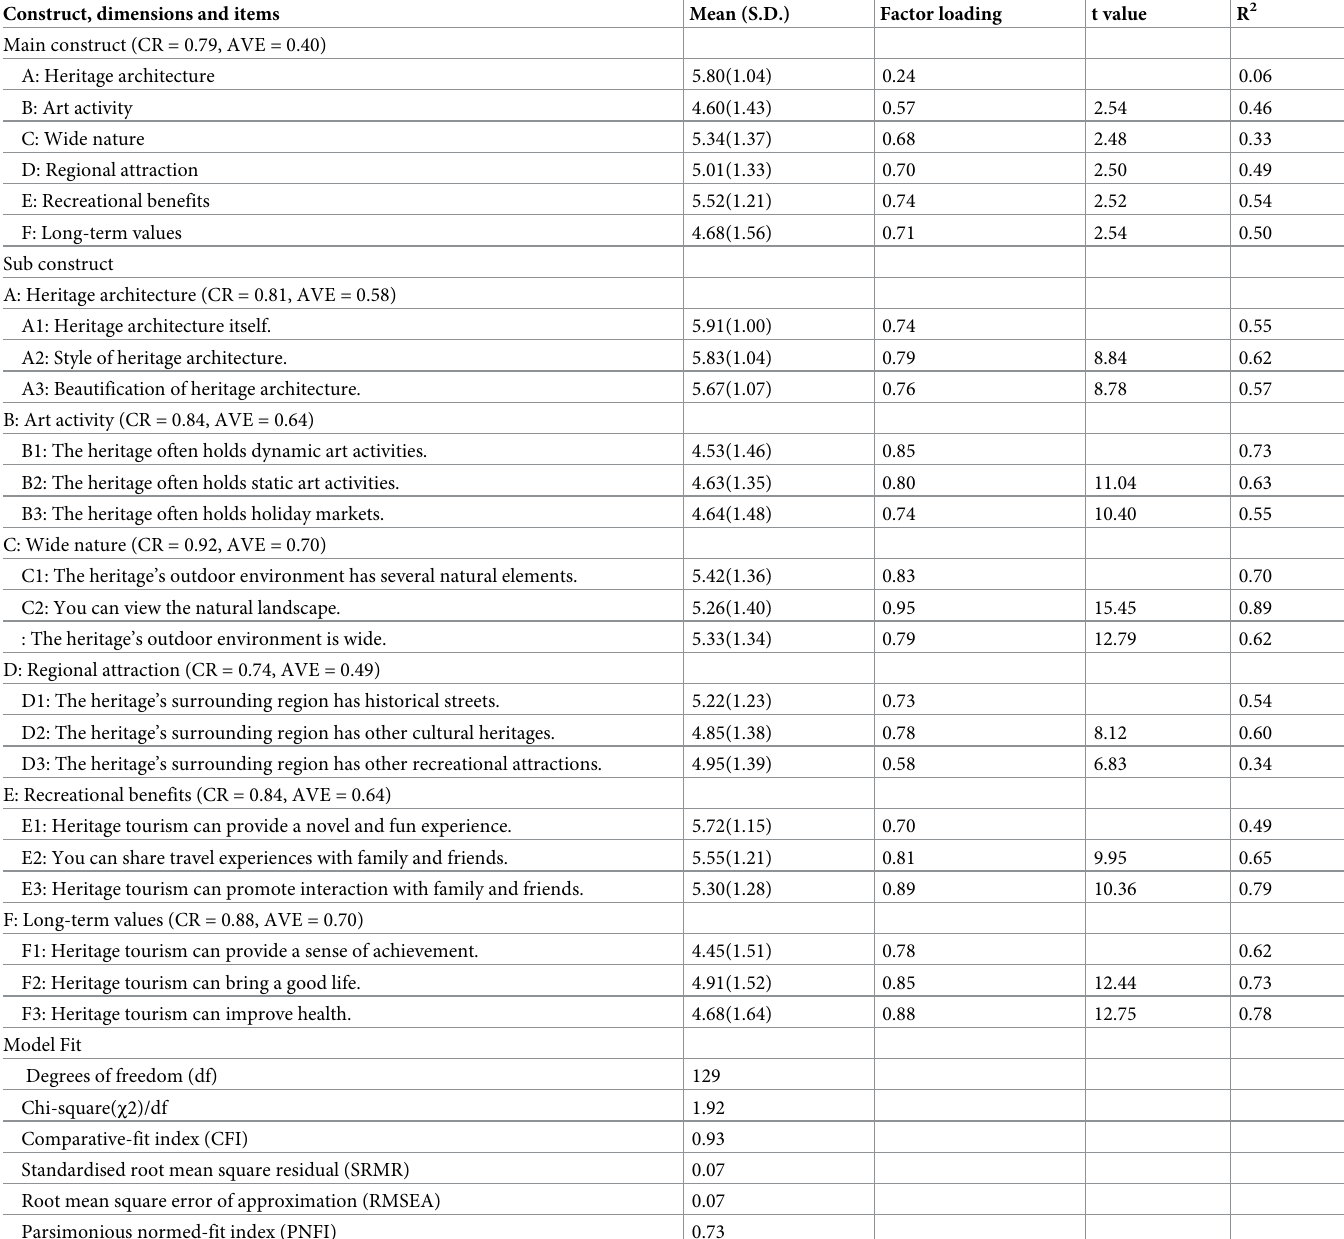
Table 5. Confirmatory factor analysis of the 18 items of the revised second-order six-factor model. Construct, dimensions and items Mean (S.D.) Factor